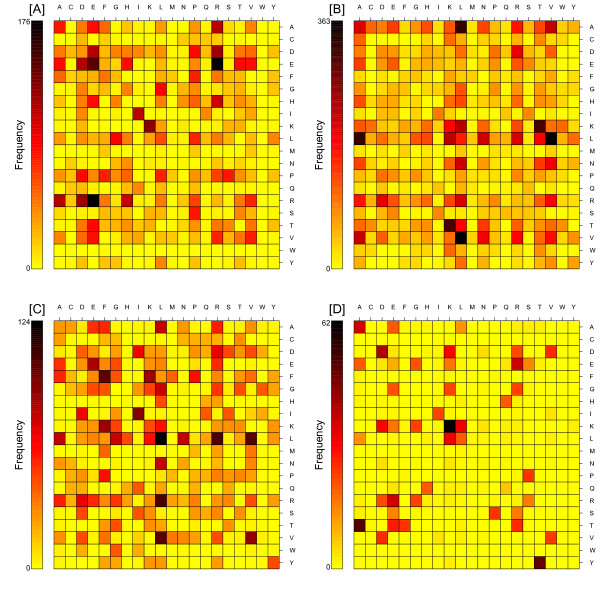
The color-coded representation of the coevolution frequency matrix of amino acid pairs inferred coevolving with respect to different properties: (A) Grantham distance, (B) polarity, (C) volume, (D) charge. The residues are arranged alphabetically.